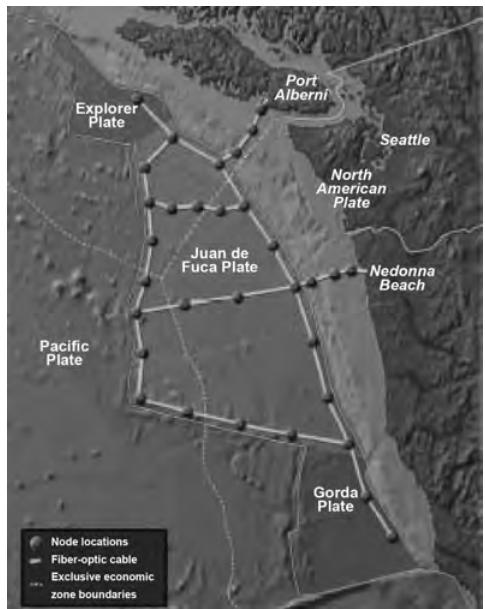
Fig. 6. Picture of the 3000-km cable planned in the NEPTUNE project to establish a lithospheric-plate scale multidisciplinary observatory network on the Juan de Fuca Plate (Delaney et al. , 2000; NEPTUNE,